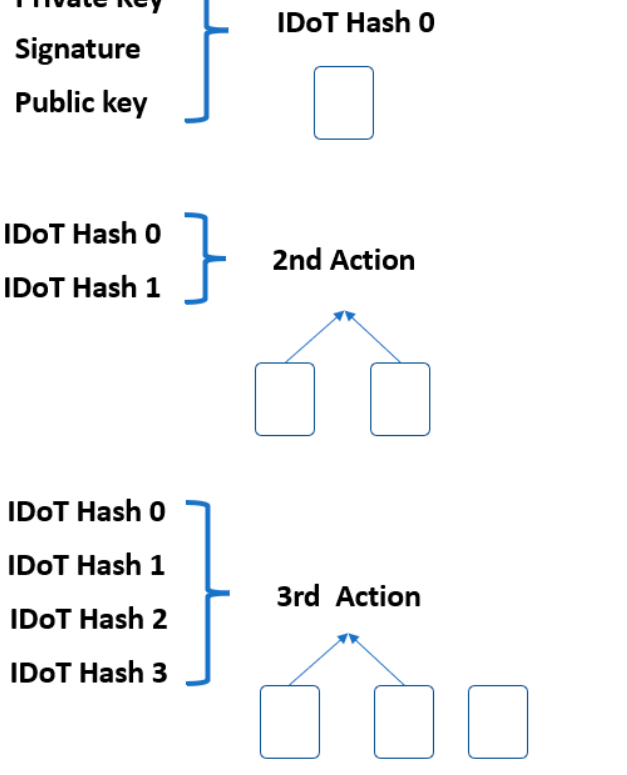
Figure 3. Transaction structure.